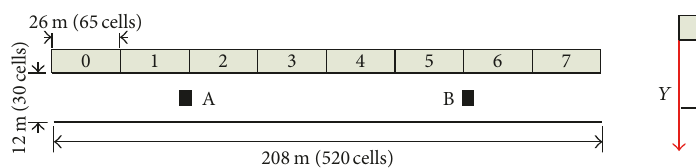
Figure 5: Definition of 𝑥 axis and 𝑦